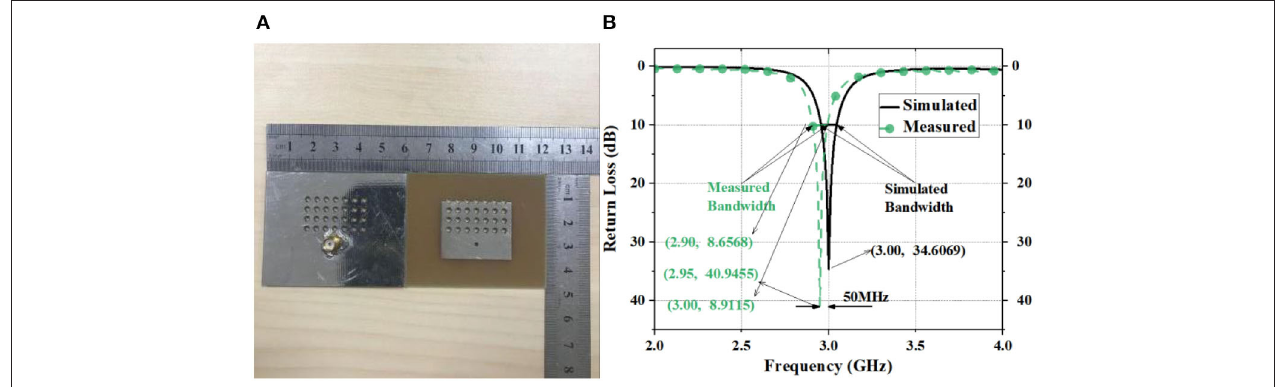
FIGURE 9 | (A) The photo of front and back of the designed antenna; (B) simulation and measurement data of the designed antenna.